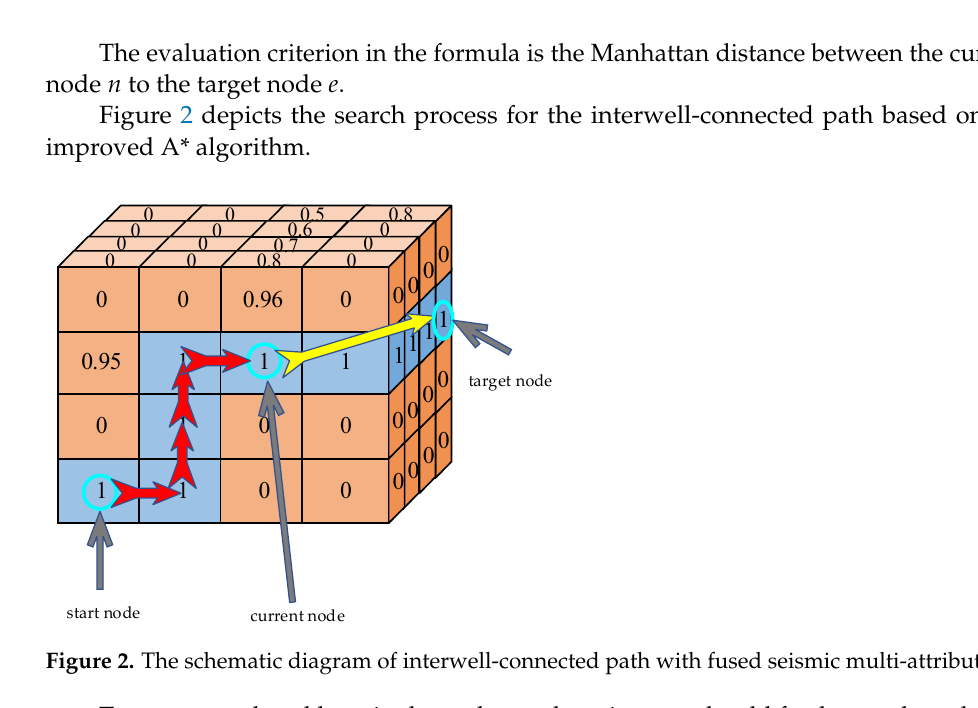
Figure 3. The schematic diagram of closed loop structure of A* algorithm .